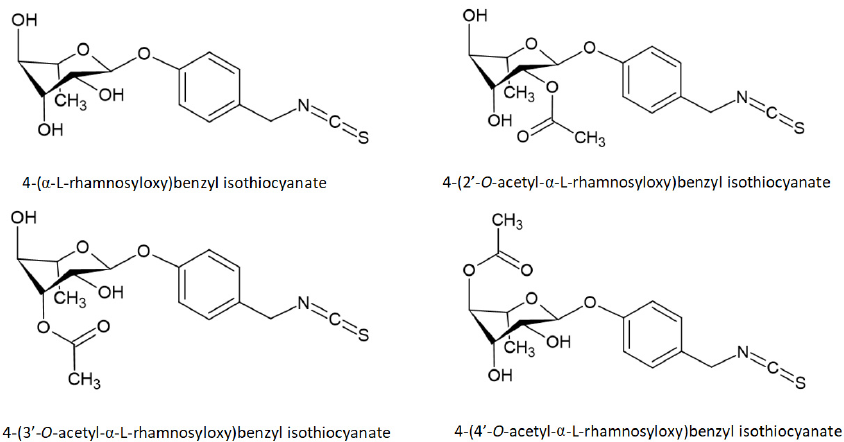
Figure 2. Chemical structures of moringa isothiocyanates.